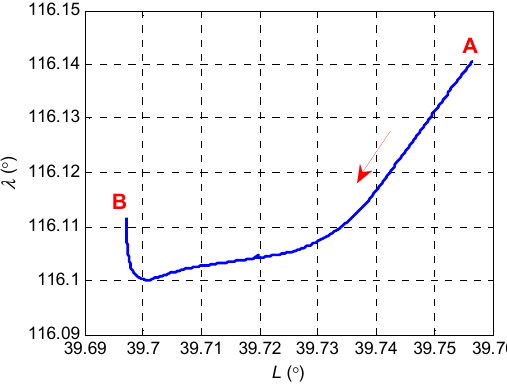
Figure 11. The trajectory of the experimental vehicle.